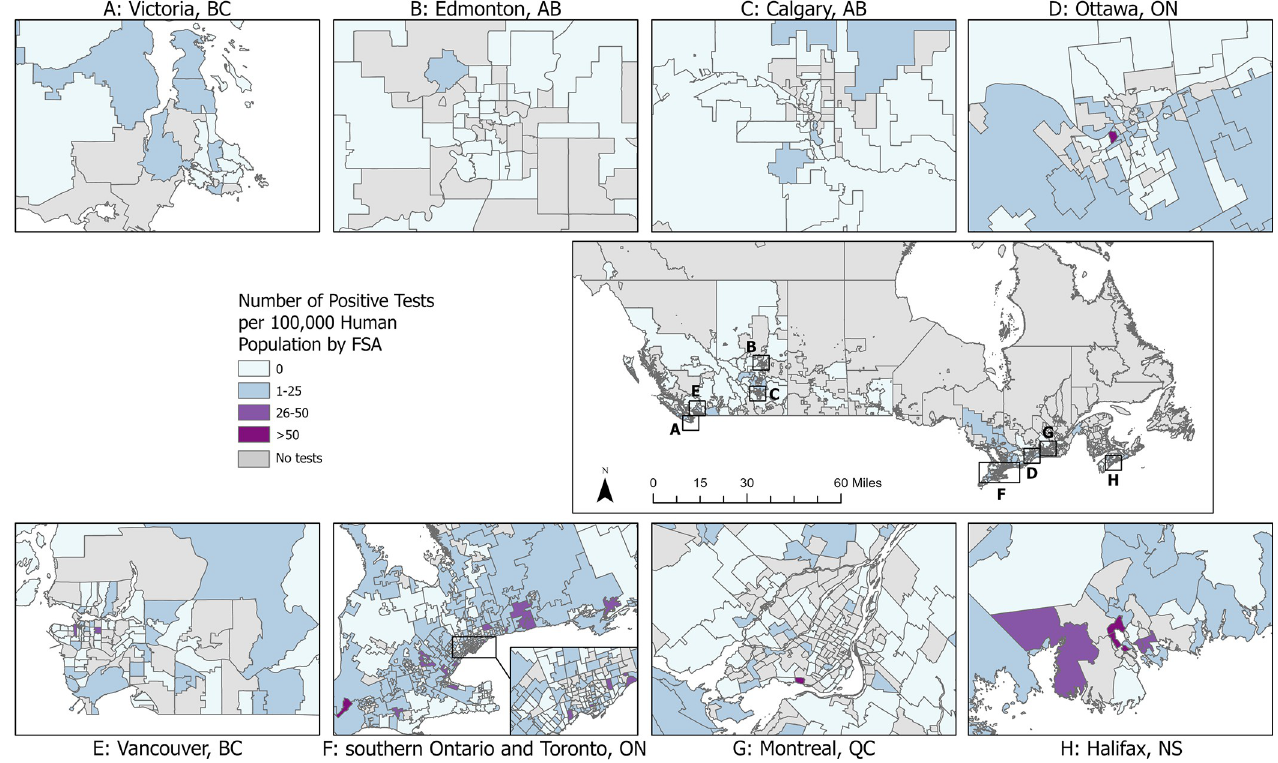
Fig 4. Number of positive canine Leptospira PCR tests per 100,000 human population by forward sorting area (FSA) in Canada, 2009–2018. FSA for submitting veterinary location.